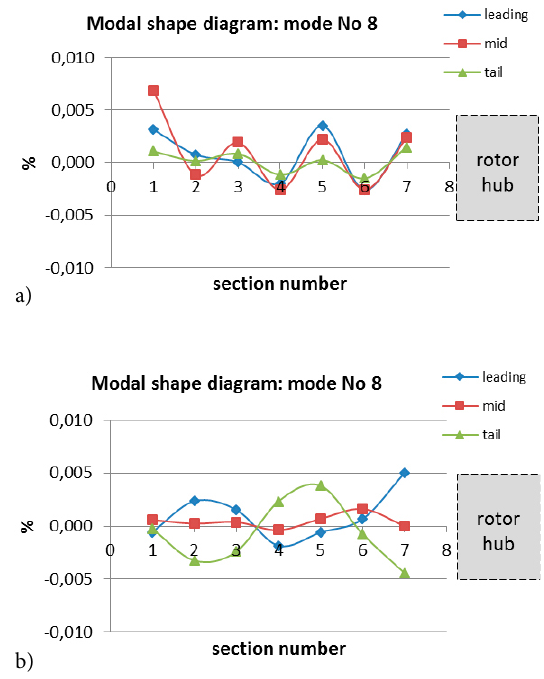
Fig. 8. Local damage identification: (a) – shape diagram of the 8 th mode; (b) – shape diagram of the 9